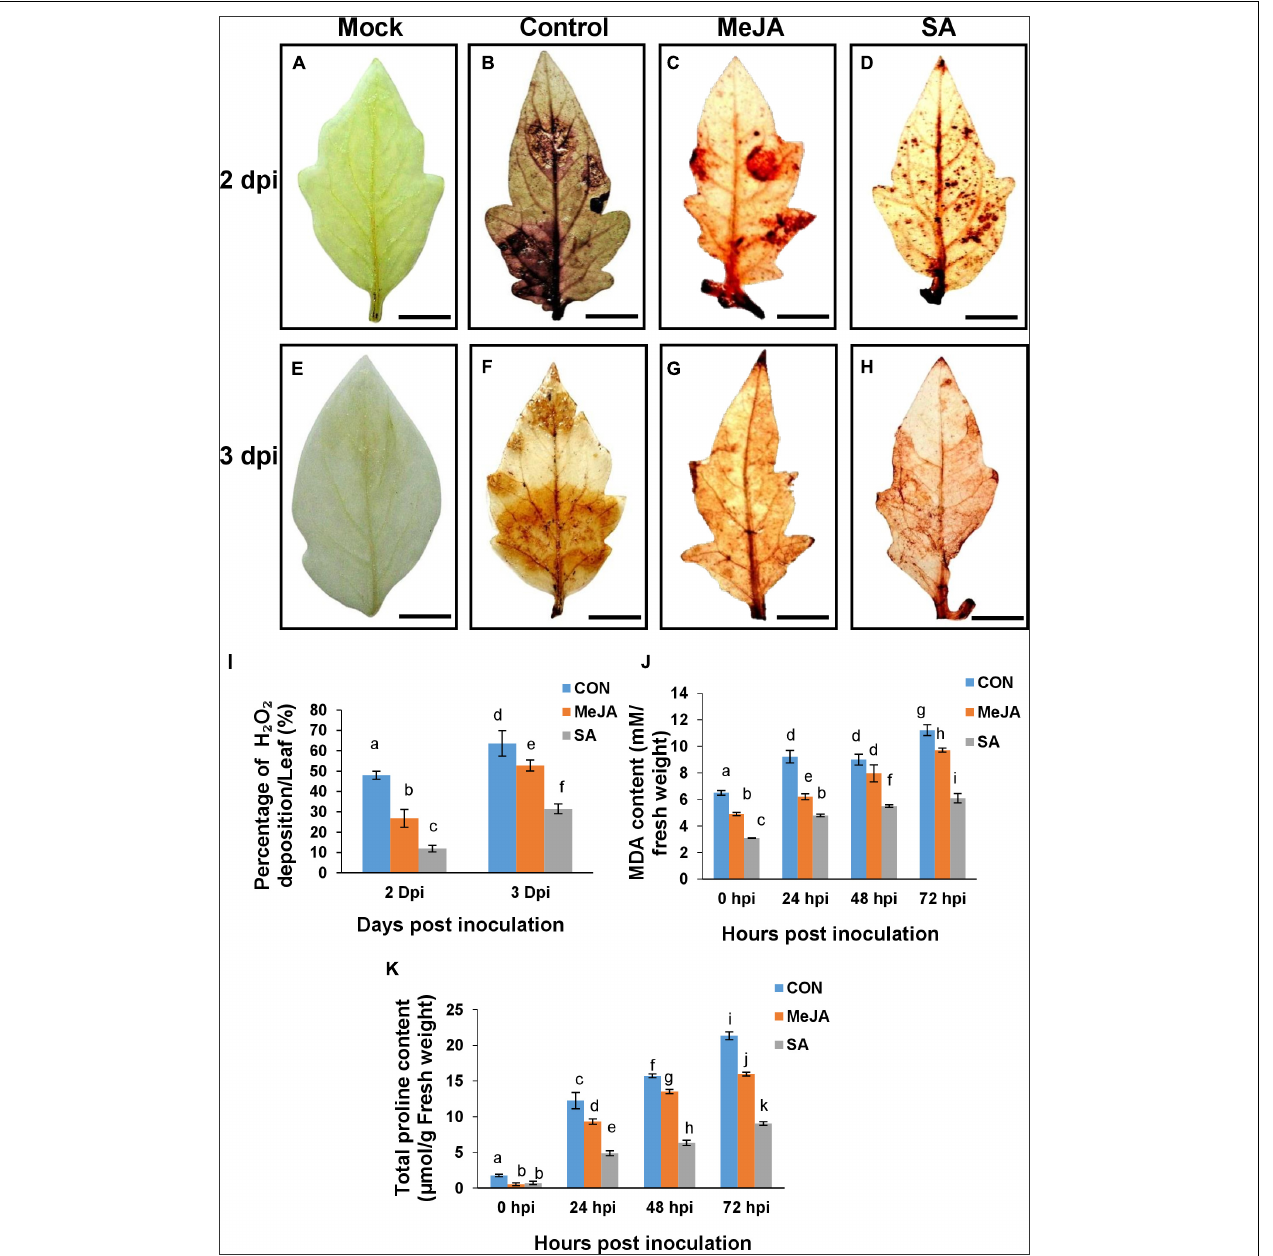
FIGURE 13 | Detection of reactive oxygen species (ROS) through Diaminobenzinidine (DAB) staining and accumulation of proline, show SA priming offered better protection against ROS during infection than MeJA priming. (A,E) Mock unprimed and uninoculated leaves showing the background color developed by the stain. (B,F) Control leaves showing deposited H 2 O 2 generated after pathogen infection at 2 and 3 dpi. (C,D,G,H) presence of ROS on the MeJA and SA pre-treated leaves, respectively. (I) Quantitative bar graph of the above result. (J) MDA content and (K) total proline content through the experimental time course. Bars represent mean ± S.E.M of six independent experiments. Different letters indicate significant differences among treatments at p < 0.05, according to Duncan’s multiple range test. Bar = 10